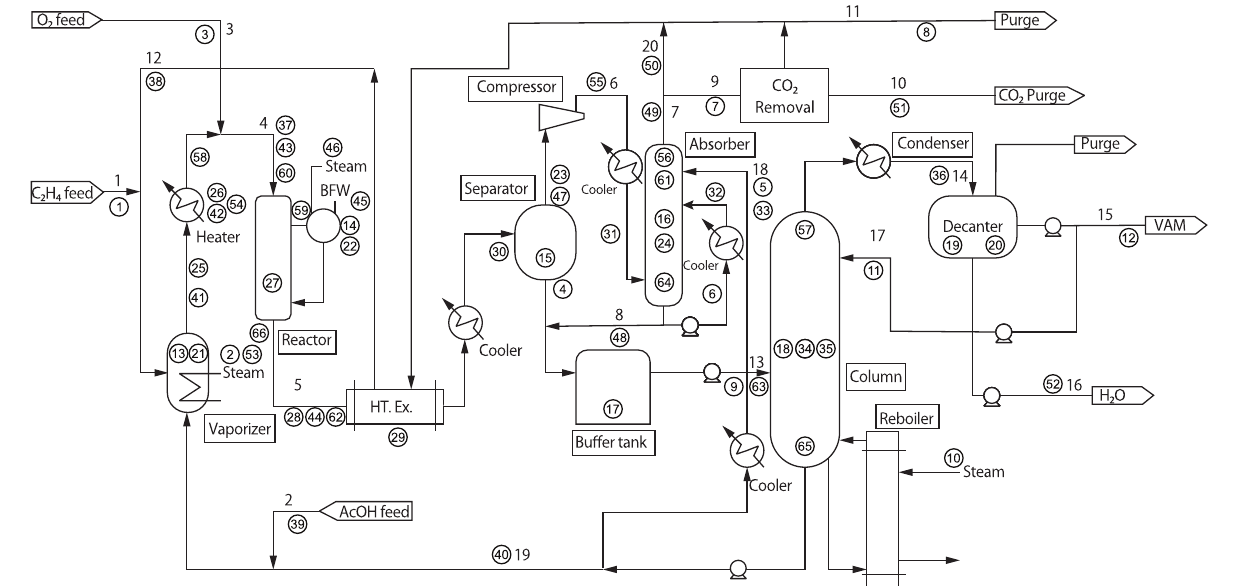
Figure 2. Process diagram of VAM process. The assigned number of the process variables was defined in the original VAM model